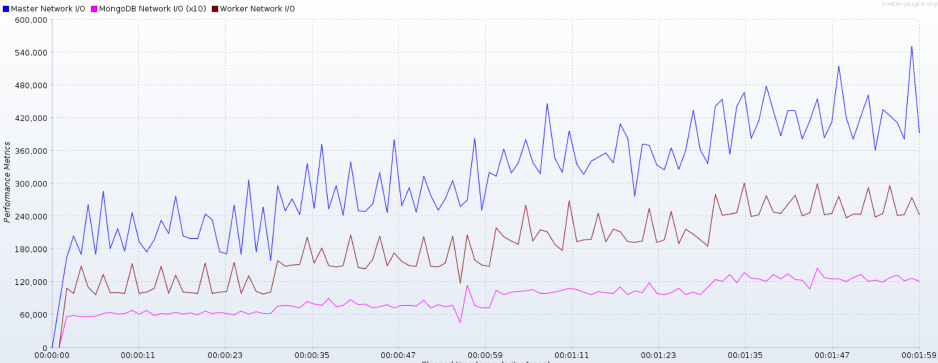
Figure 17. Distributed deployment: Resource utilization reported by ( a ) MongoDB and ( b ) the workers for the task “Send alert”.